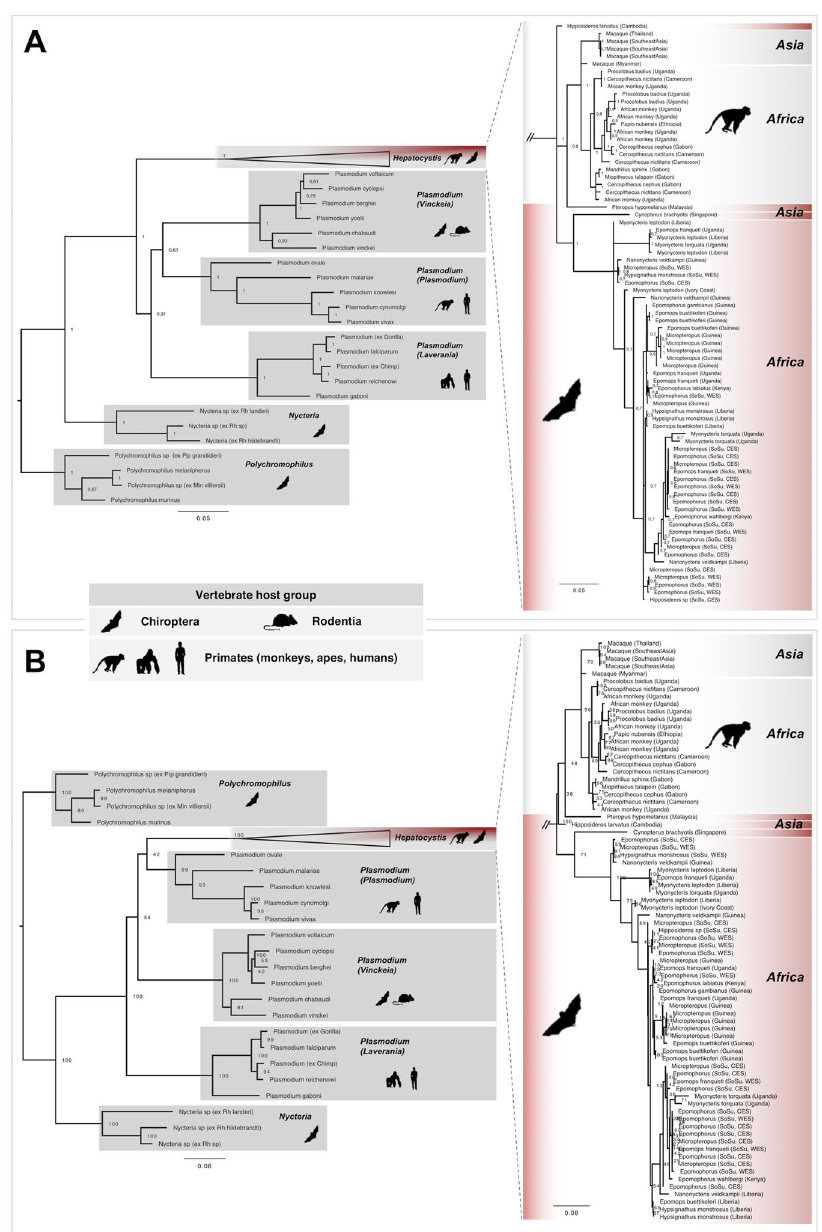
Figure 2. Three-genome phylogeny for Hepatocystis parasites in the context of the mammalian haemosporidian parasite clades. The concatenated phylogenies were obtained via analysis of four genes, the mitochondrial cytochrome b and cytochrome oxidase 1, the apicoplast caseinolytic protease and the nuclear elongation factor 2. The Hepatocystis clade is shown as collapsed clade (on the left) and this section is enlarged and uncollapsed on the right site. The Hepatocystis clade falls in two distinct groups, the primate Hepatocystis clade with the exception of two samples recovered from the bat hosts Pteropus hypomelanus and Hipposideros larvatus and an African fruit bat Hepatocystis clade with the exception of a sample recovered from the Asian fruit bat Cynopterus brachyotis , which each group as sister to the main groups respectively. ( A ) Three-genome phylogeny for Hepatocystis parasites recovered by Bayesian analysis. Posterior probability values are given. Placement of Hepatocystis parasites as sister to the mammalian Plasmodium clade with good support (1). ( B ) Three-genome phylogeny for Hepatocystis parasites recovered by maximum likelihood analysis. Bootstrap values are given. Placement of Hepatocystis parasites as sister to the mammalian Plasmodium vivax/malariae clade with low support